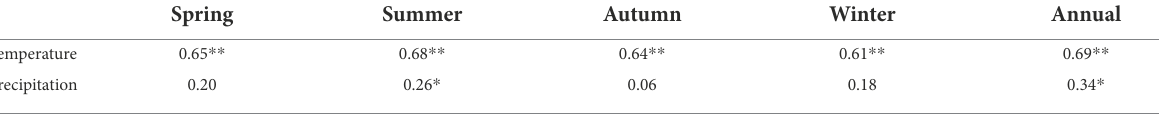
TABLE 3 Correlation coefficients between marsh AGB and seasonal climatic variables in Northeast China. Spring Summer Autumn